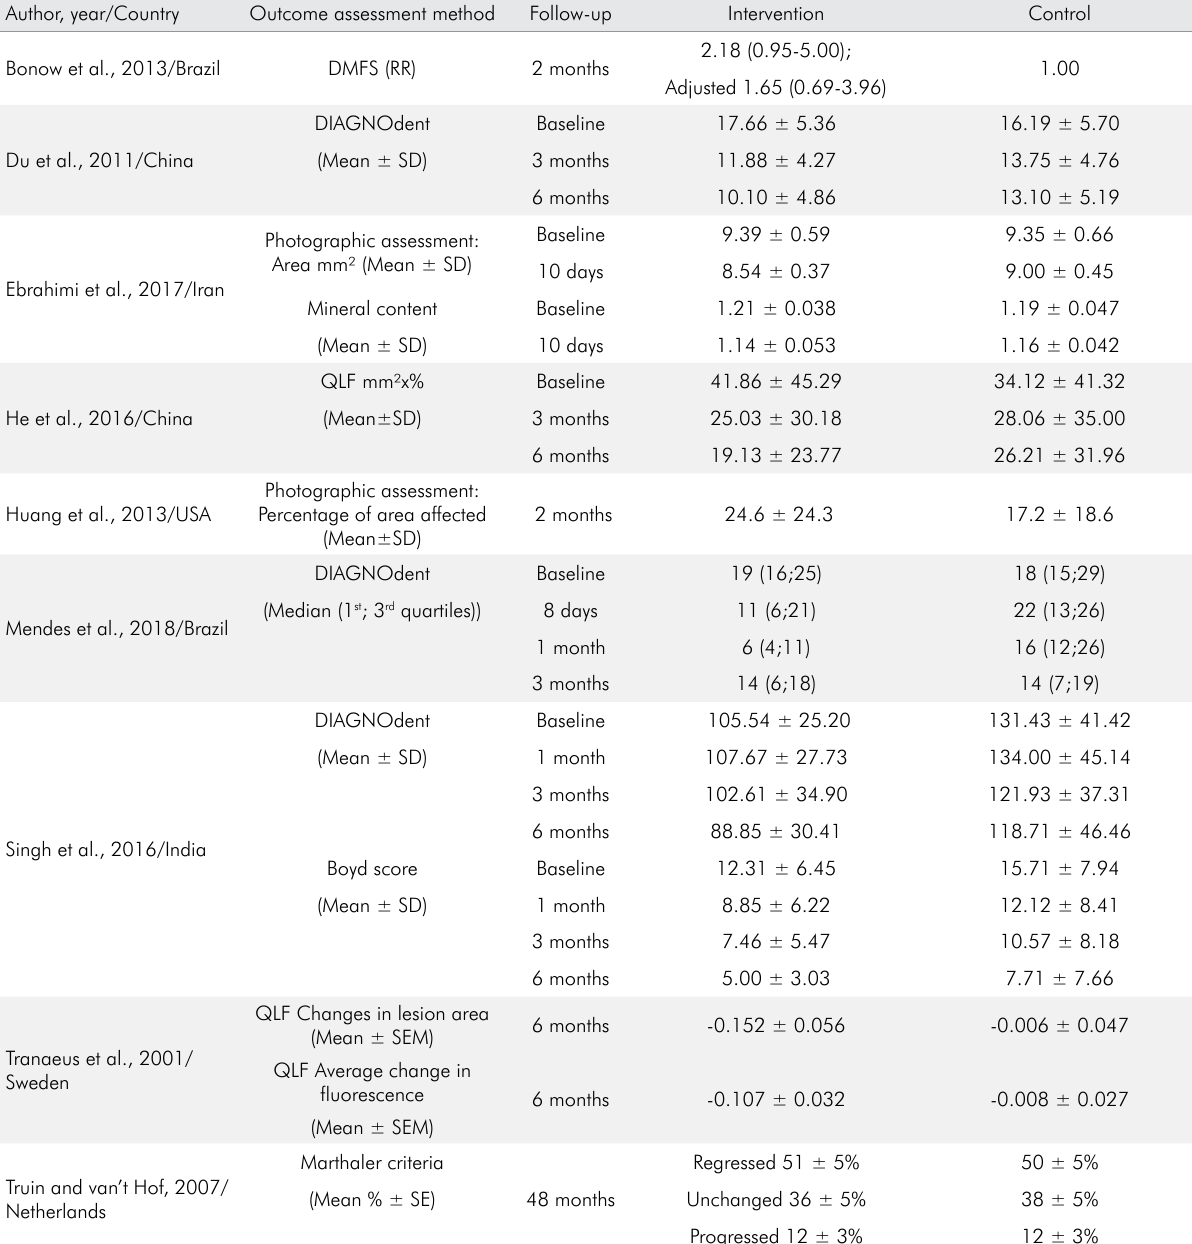
Table 4. Results of individual